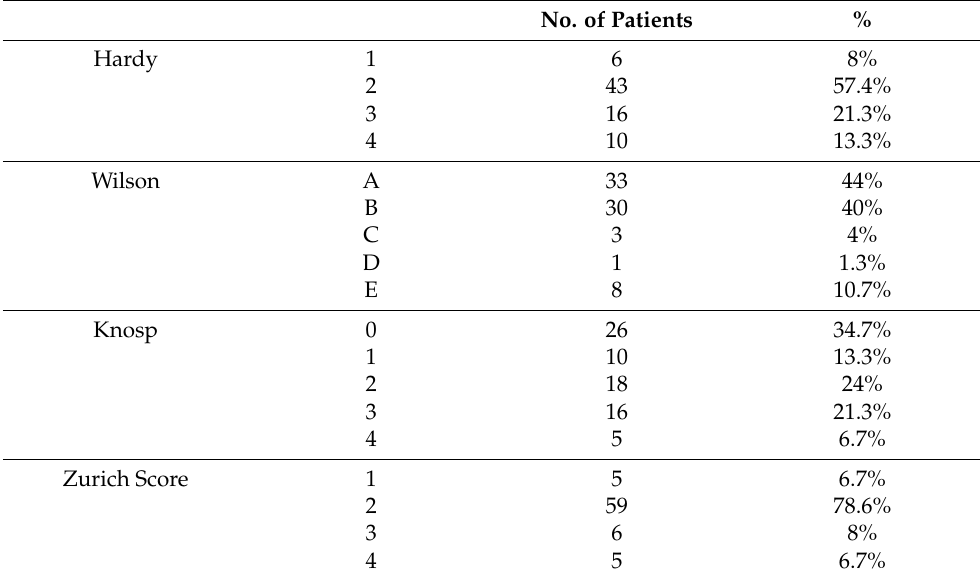
Table 2. Neuroradiological pre-operative features of the patients.